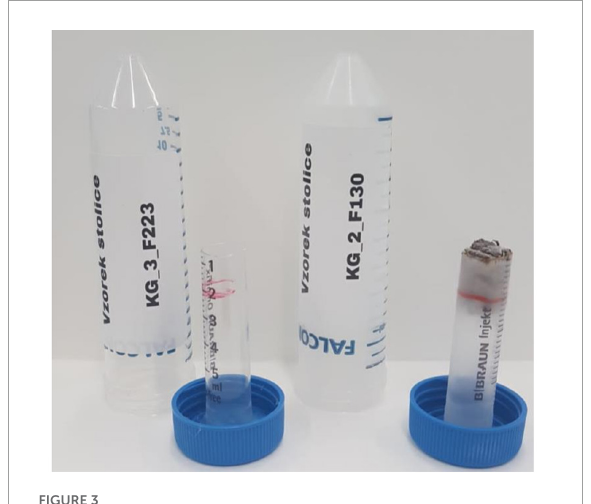
FIGURE3 Special in-house tubes before (left) and after (right) collection of one 1.5–2 ml stool